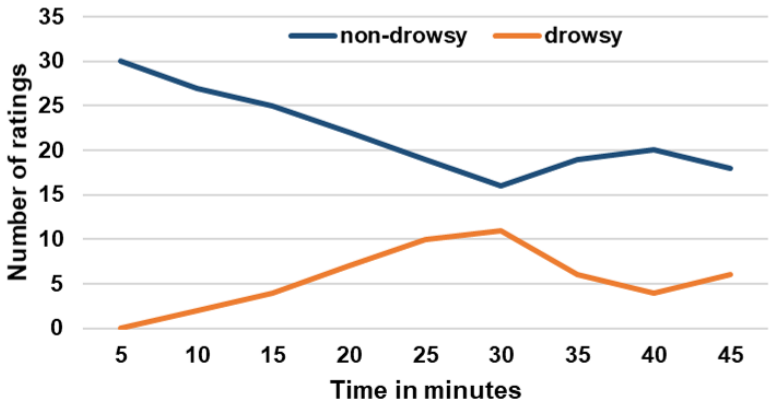
Figure 3. Localization in time of number of ratings for both the “non-drowsy” and “drowsy”